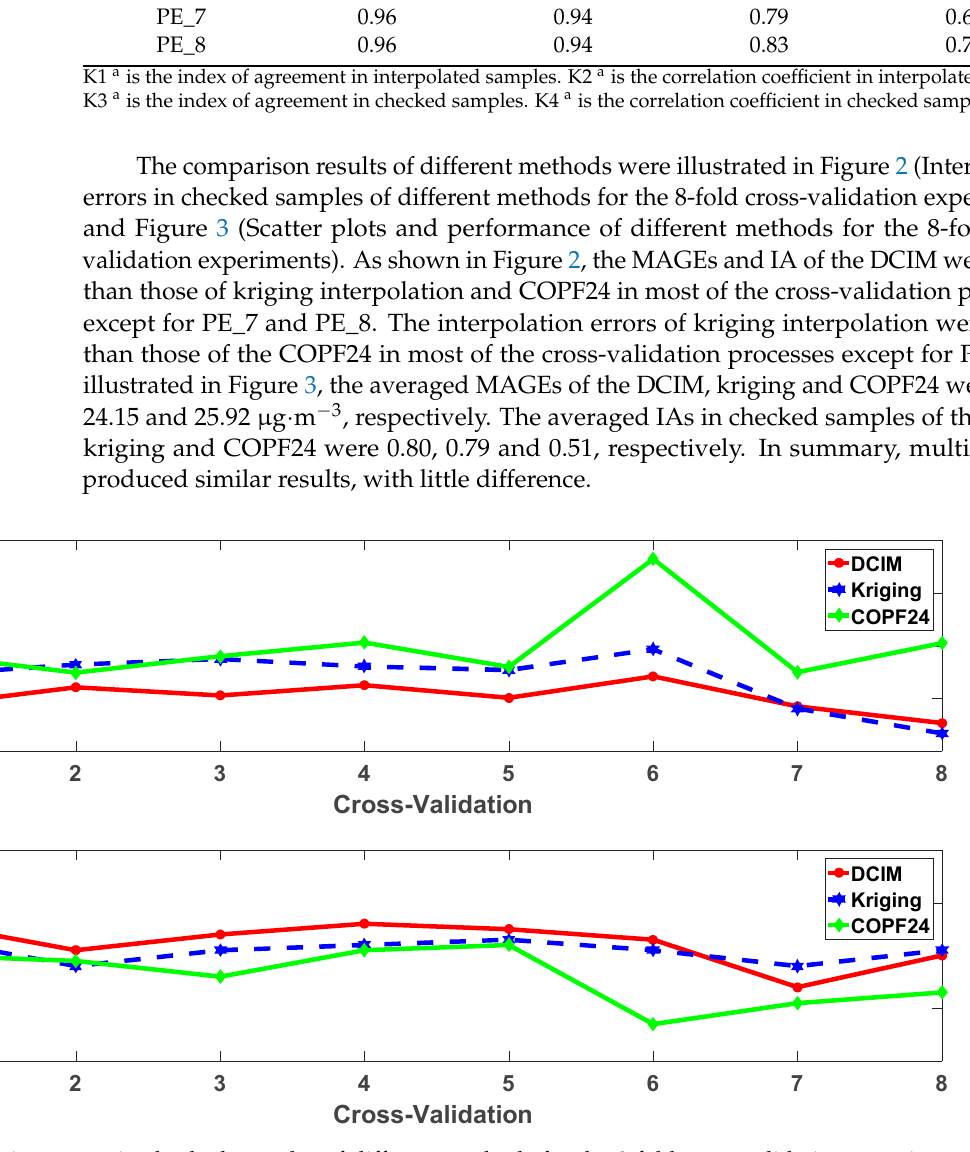
Figure 3. Scatter plots and performance of different methods for the 8-fold cross-validation ex- periments on 8–11 November 2014: ( a ) Performance of the 8-fold cross-validation DCIM simula- tions in the interpolated samples, ( b ) Performance of the 8-fold cross-validation DCIM simulations